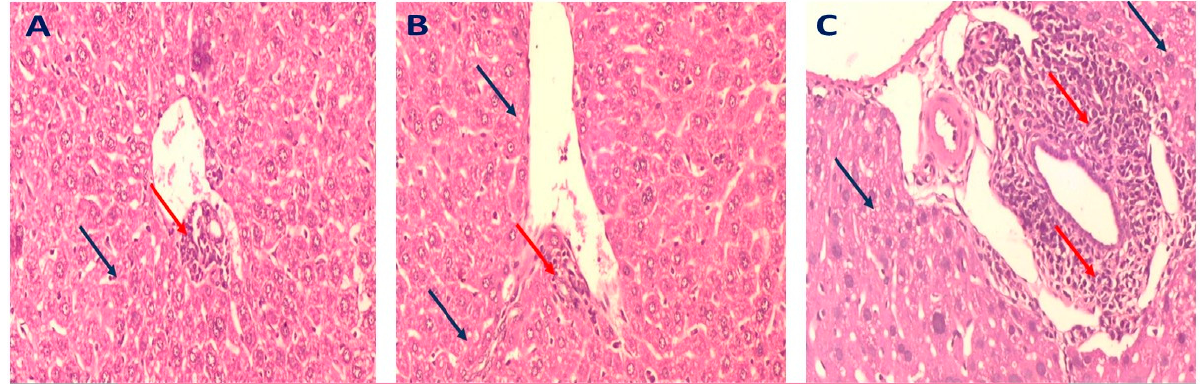
Figure 7. Representative photomicrograph of a liver section of mice groups that received different doses of rutin (H&E, × 200) as follows: ( A ); mice group that administered rutin at 50 mg/kg: displayed portal tract surrounded by marked inflammatory cellular infiltrate (red arrows) and hepatocytes with moderate steatosis (blue arrow). ( B ); mice group received rutin at 75 mg/kg: section of the liver showing portal tract surrounded by minimal inflammatory cellular infiltrate (red arrow) and hepatocytes with minimal steatosis and degeneration (blue arrows). ( C ); mice group that received rutin at 100 mg/kg: showed a portal tract surrounded by marked inflammatory cellular infiltrate (red arrows) surrounded by hepatocytes with moderate steatosis (blue arrow).